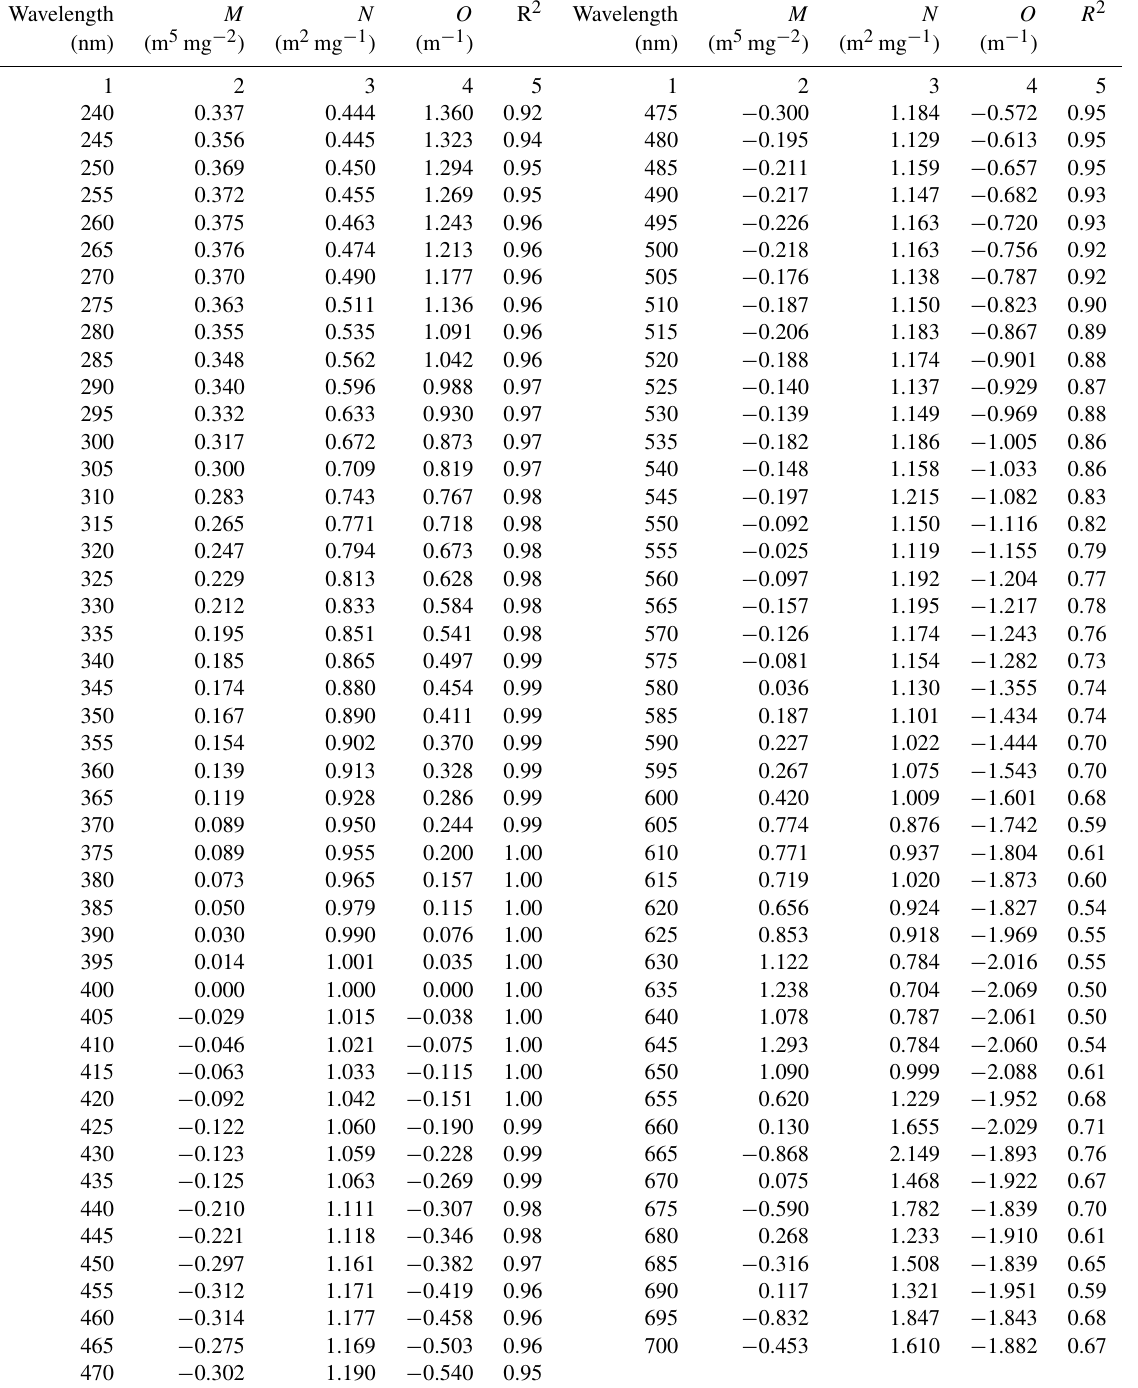
Table B1. Parameters of the model of light absorption by CDOM (Eq. 14) for the wavelength range 240–700nm, shown for intervals of